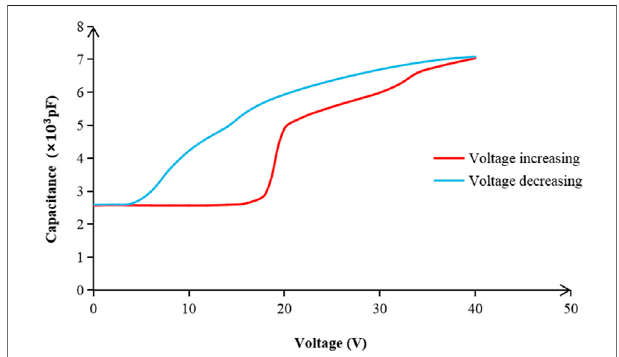
FIGURE 4 | | Hysteresis characteristic curve of an EWD panel. A step voltage from 0 to 40 V was used to measure the rising edge curve. The step time was 2 s and the step voltage was 2 V. A step voltage from 40 to 0 V was used to measure the falling edge curve. The step time was 2 s and the step voltage was − 2 V.